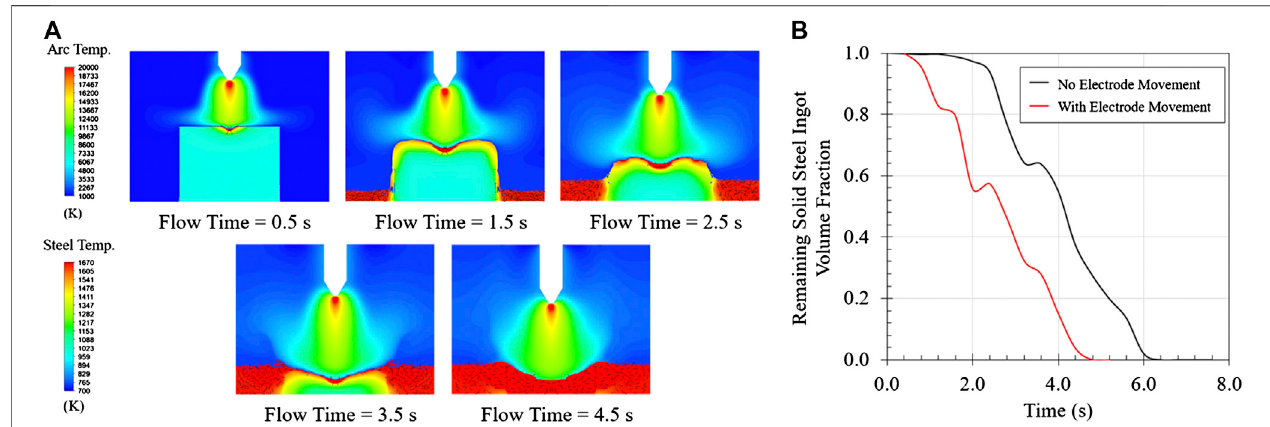
FIGURE 10 | (A) Steel ingot melting using electric arc with dynamic moving electrode. (B) Comparison of steel ingot melting ef fi ciency with and without dynamic moving electrode.